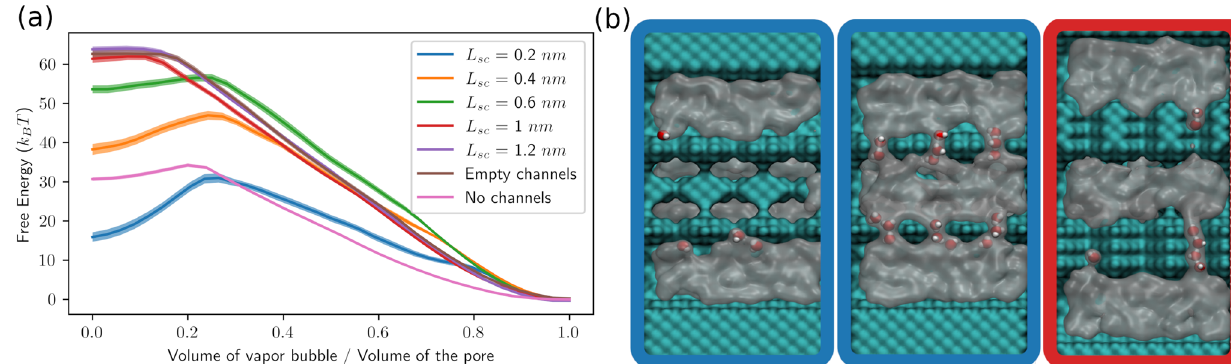
Fig. 2 Free energy depends on the lengths of the secondary channels. a Free energy as a function of the normalized volume of the bubble in the main pore for different lengths of the secondary channels, L sc , 0.2 nm (blue), 0.4 nm (orange), 0.6 nm (green), 1 nm (red), and 1.2 nm (pink); as a reference, we also report the case with no channels (purple) and the case in which the channels are kept forcefully empty (brown). The arbitrary constant of the free energy is set such that it is equal for all the systems for an empty central pore. The standard error of the free energy pro fi le is shown using a shaded region around the curve. b The panels circled in blue show a snapshot of the empty and fi lled states of the central pore for L sc = 0.2 nm; the panel circled in red shows the fi lled state for L = 1 nm. Water is represented as a transparent fl uid, while the water molecules inside the secondary channels are explicitly shown to sc highlight the different levels of fi